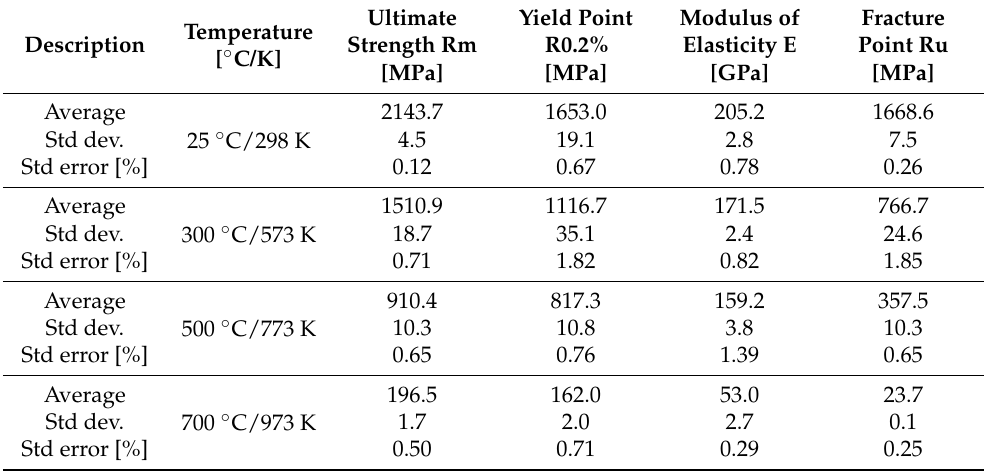
Table 2. The results of tensile tests of Armstal 550 armour steel for all temperature levels.